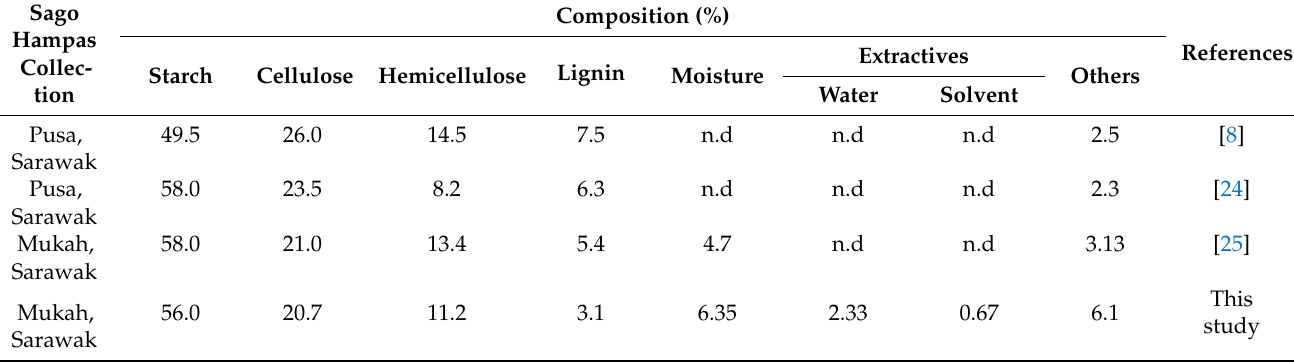
Table 3. Comparison of the composition of raw sago hampas with a different collection of sago hampas. Sago Composition (%)